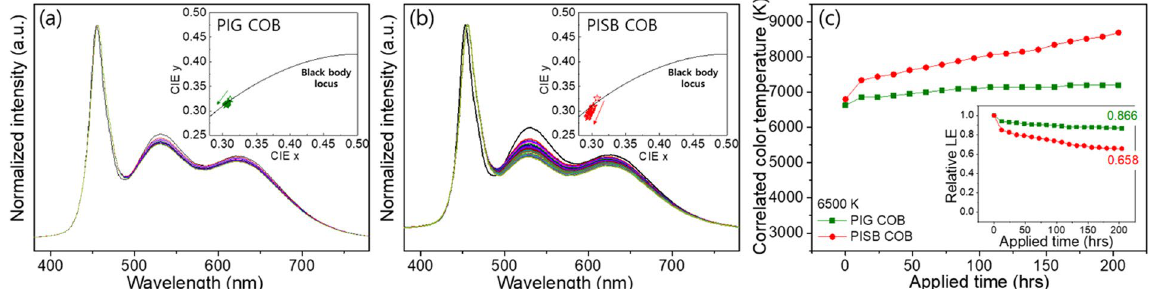
Figure 8. The spectrum results of the 6500 K ( a ) on-chip PIG WLED and the ( b ) on-chip PISB WLED for ~200 hours of long-term measurements. Insets show each CIE coordinate and arrows indicate an increase in the operation time. ( c ) The CCTs of the on-chip PIG and PISB WLEDs. Inset diagram shows the LE values of the corresponding on-chip PIG and PISB